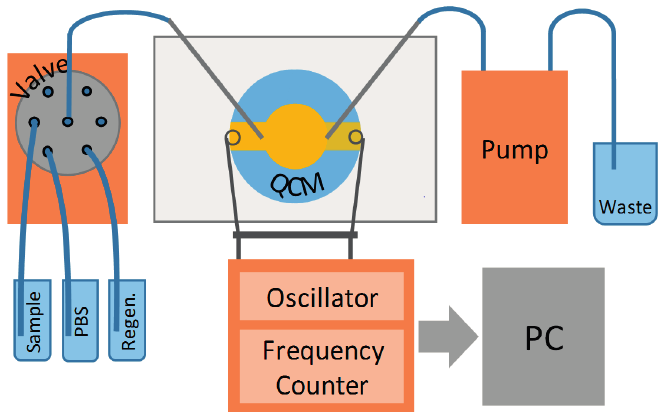
Figure 1. Scheme of experimental set-up for active QCM